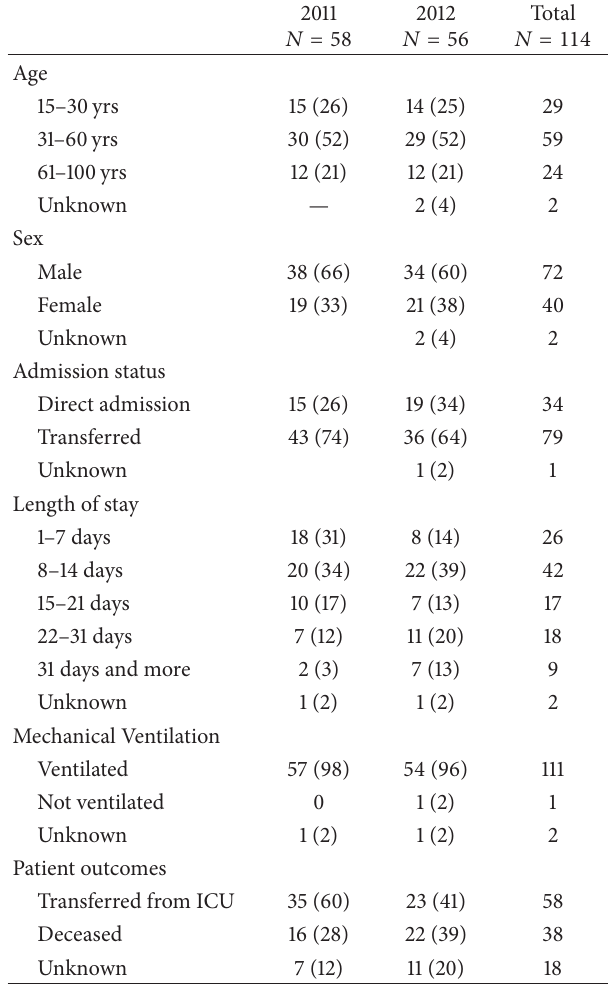
Table 1: Characteristics of bacteriologically-confirmed nosocomial infections from an adult intensive care unit